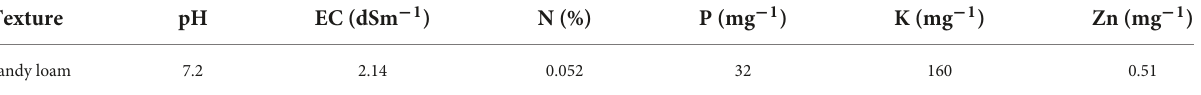
Figure 2 designates the effect of different concentrations of foliar application of ZnO NPs on root fresh and dry weights